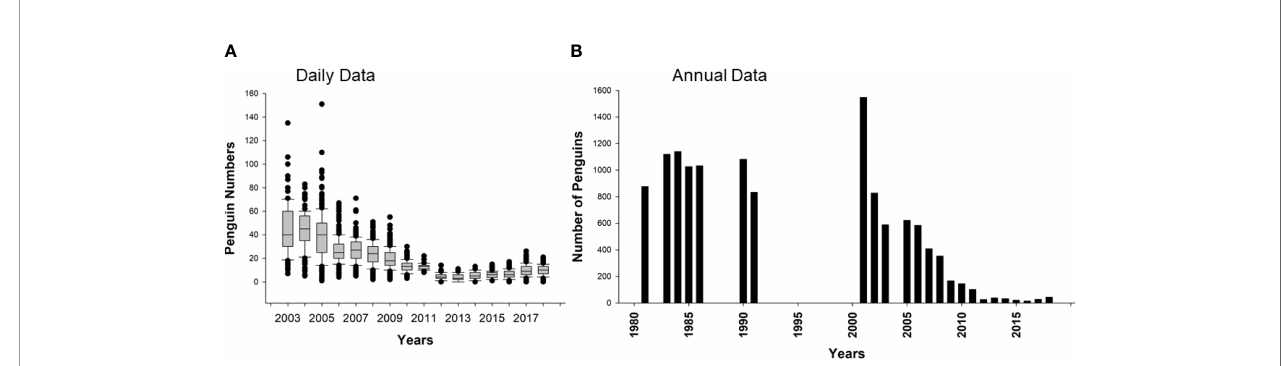
FIGURE 4 | (A) Monthly data: Average number per year of little penguins observed during the North Shore night tours between January 2003 and December 2018. (B) Annual data: Estimated population size of little penguins on Granite Island between 1981 and 2018. Missing data represent years when no census or